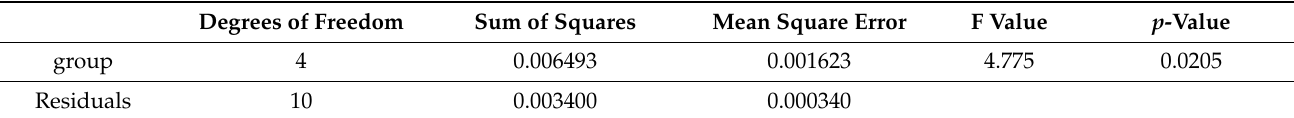
Table 6. Results of ANOVA.